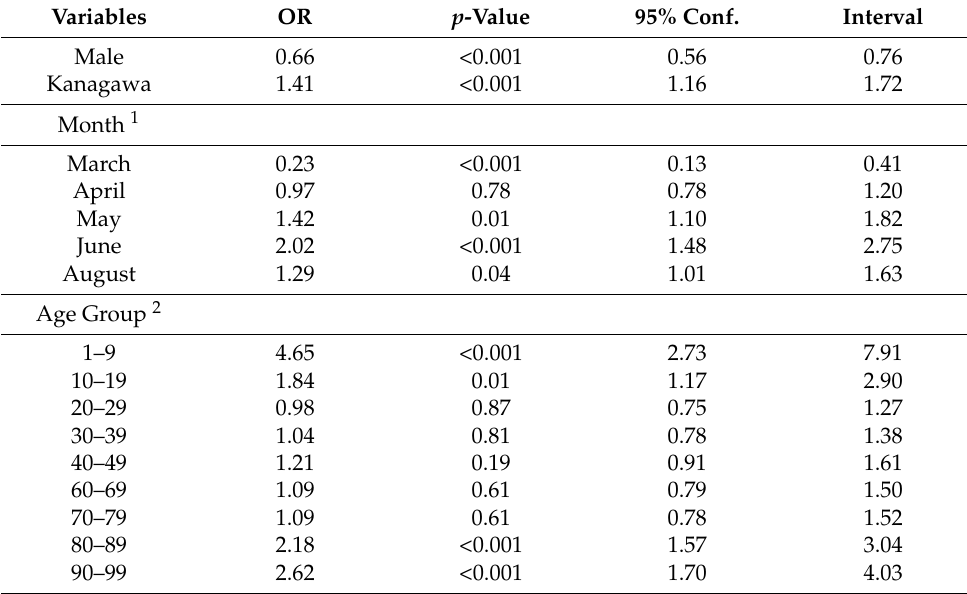
Table 3. Logistic Regression for the Determinants of Asymptomatic Status.